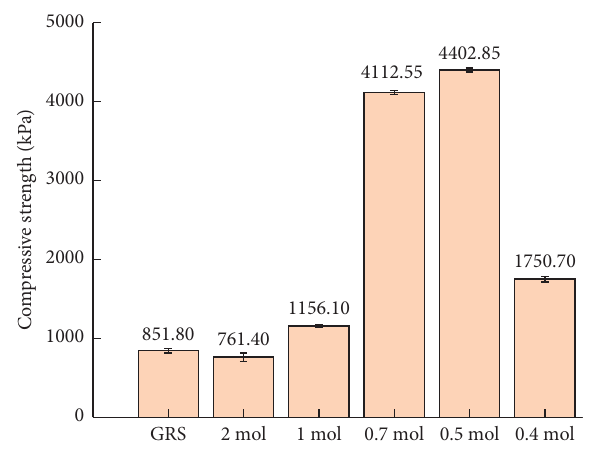
Figure 6: Compressive strength.